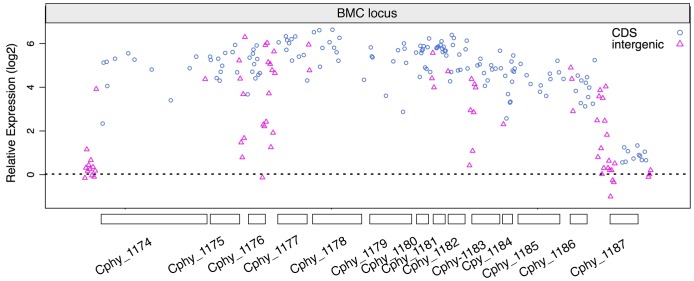
Expression values of individual probes within the BMC locus.Expression values were calculated from the average of two rhamnose measurements divided by the average of two glucose measurements. Each coding sequence is represented by eleven 24-mer probes. The intergenic regions have a variable numbers of probes depending on the length of the region.